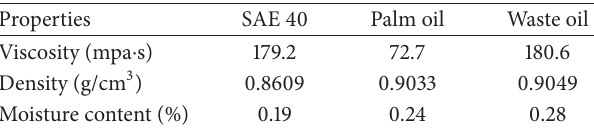
Table 4: Properties of baseline oil.